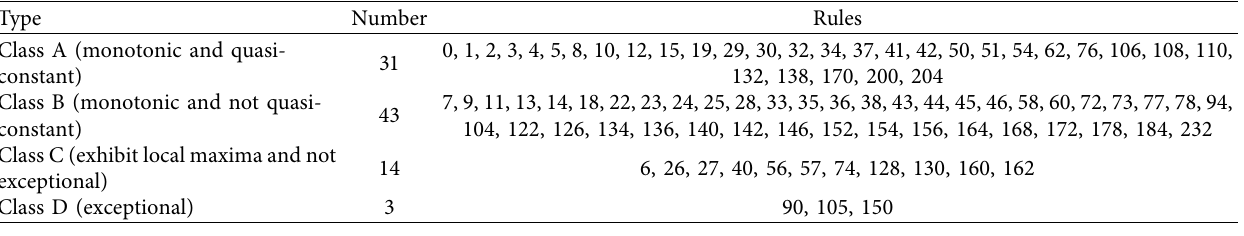
Table 1: Classification of the rules into four classes, corresponding to the analysis of our results.